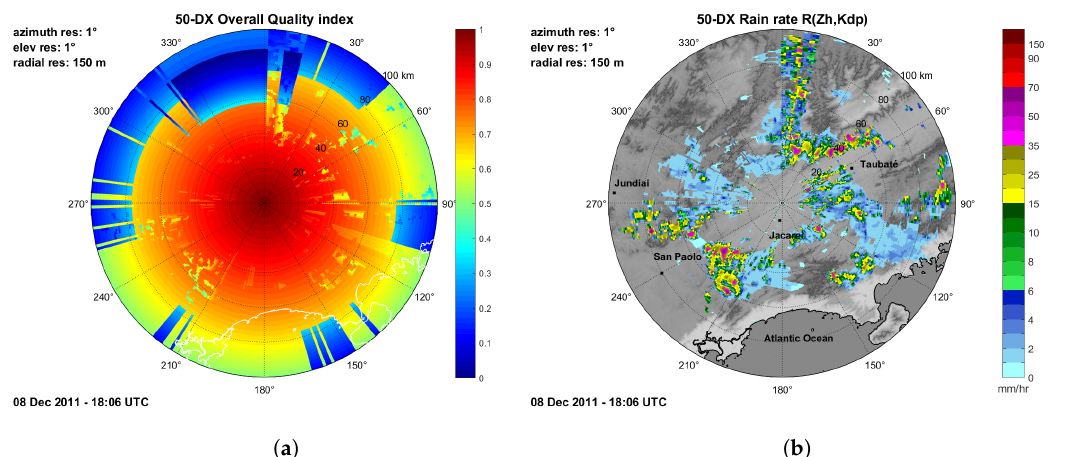
Figure 18. ( a ) Overall radar quality index and ( b ) Rain rate from radar on 8 December 2011 at 18:06 UTC.